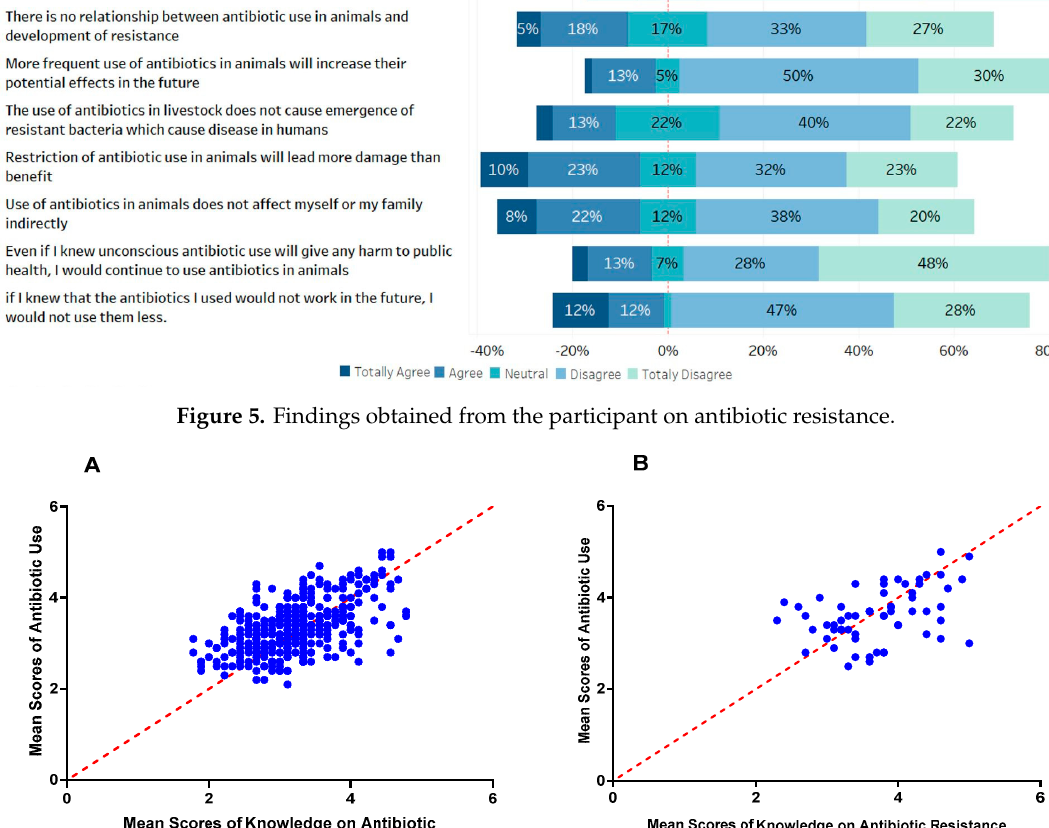
Figure 6. Correlation graphs showing the association between antibiotic use and knowledge on antibiotics ( A ) and knowledge on antibiotic resistance ( B ).